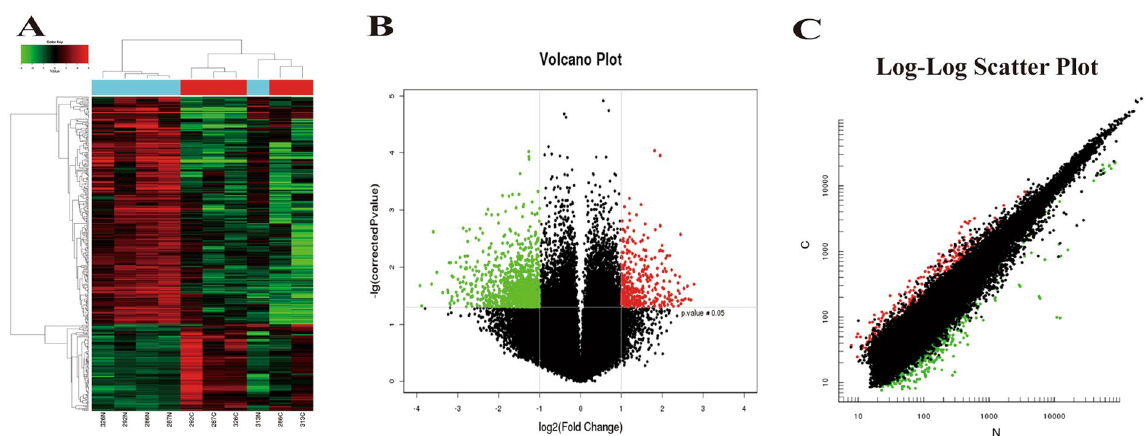
Figure 1. Hierarchical clustering, volcano plots, and scatter plots exhibited the differentially expressed circRNAs in gastric cancer tissues compared to paired non-gastric cancer tissues. ( A ) Hierarchical clustering, numbers were the samples used for the microarray assay. C: cancer tissues, N: non-cancerous tissues. ( B ) Differentially expressed circRNAs were displayed by volcano plots. The green and red parts indicated > 2 fold- decreased and -increased expression of the dysregulated circRNAs in GC tissues, respectively (p < 0.05). ( C ) Differentially expressed circRNAs were displayed by scatter plots. The green and red parts indicated > 2 fold- decreased and -increased expression of the dysregulated circRNAs in GC tissues (p < Labeling and hybridization. After removing linear RNAs with ribonuclease R, RNA (5 μ g from each sam- ple) was reverse transcribed into cDNA using random primers containing T7 promoter by First Strand Enzyme Mix Kit. The DNA-RNA mixture was transformed to the second strand DNA by Second Strand Enzyme Mix. This